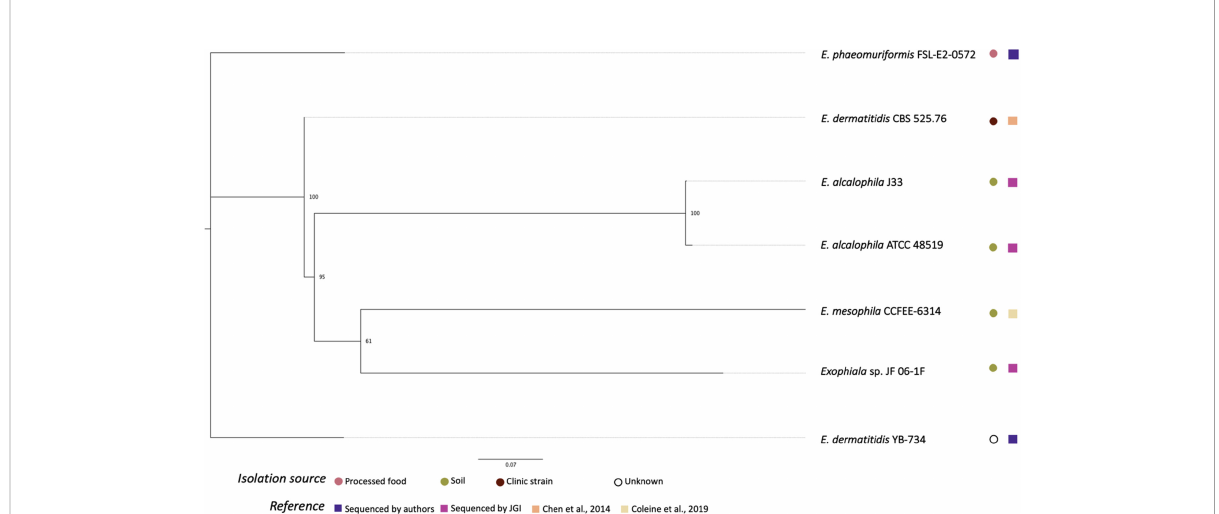
FIGURE 2 Phylogenetic relationships of Exophiala strains inferred from SNP alignment. Bootstrap values observed among 1,000 replicates are indicated. The phylogenetic tree was midpoint rooted and the scale bar denotes the number of nucleotide substitutions per